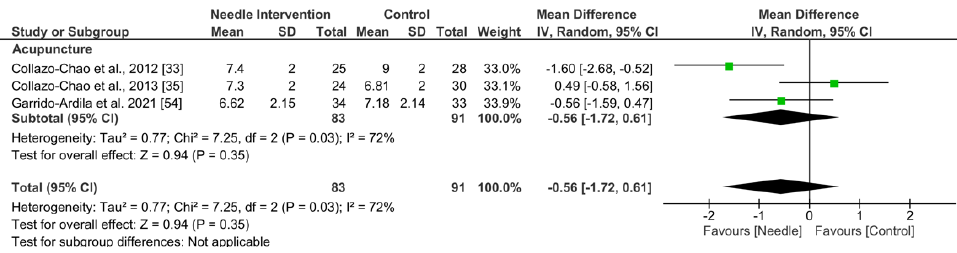
Figure 3. Forest plot for Pain Intensity: 3 to 6 months.